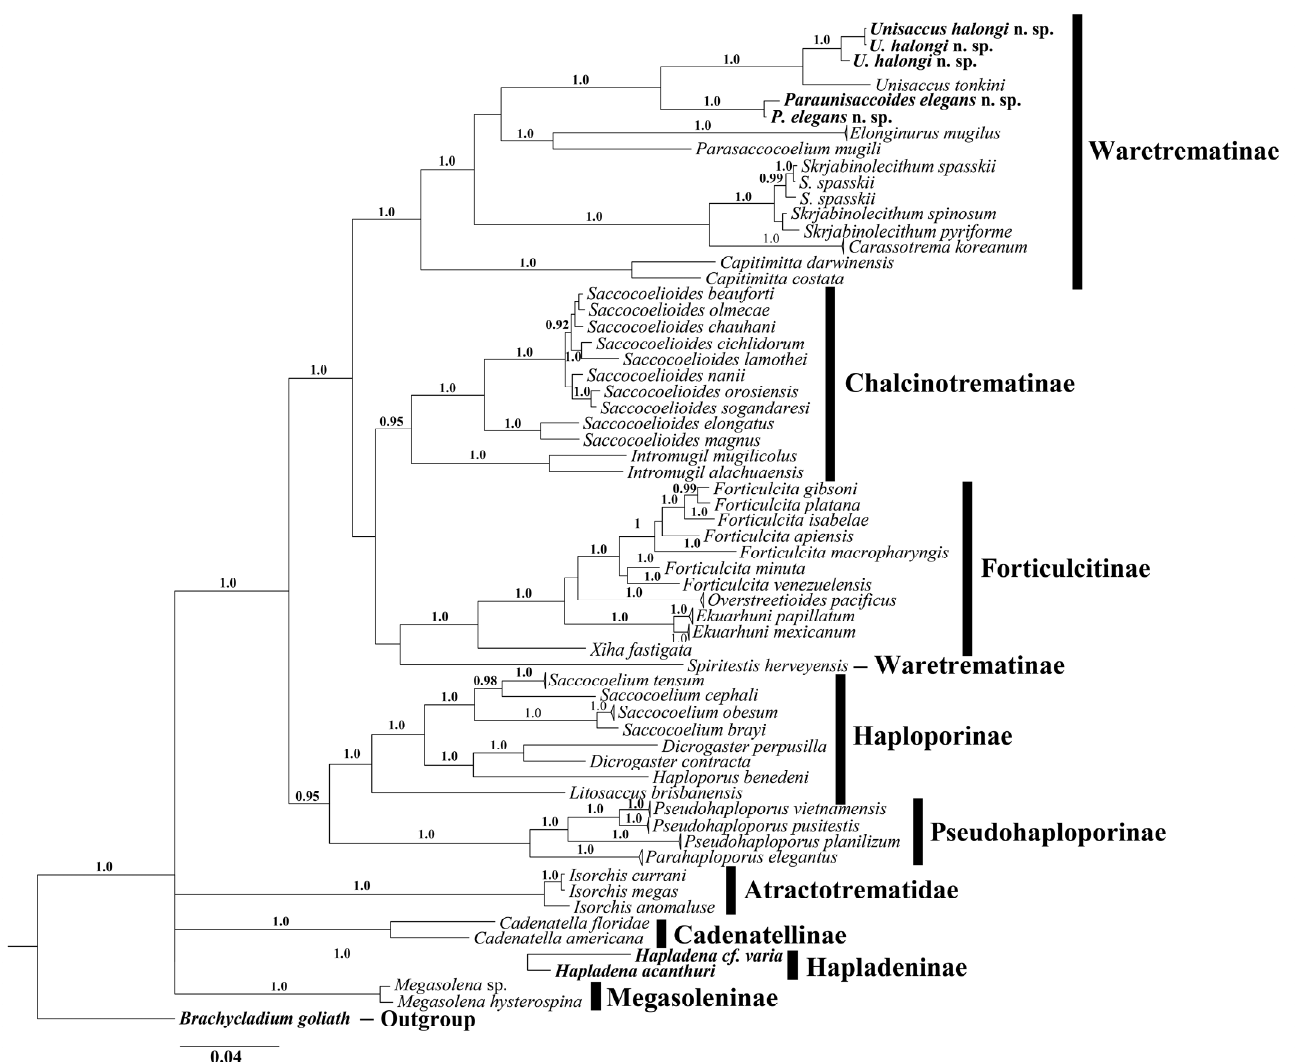
Figure 3. Phylogenetic relationships of the family Haploporidae obtained with Bayesian algorithm based on concatenated ribosomal ITS2 and partial 28S rRNA gene (alignment length 1460 bp). Nodal numbers—posterior probabilities that indicate statistical support of phylogenetic relationships, only significant values (0.9–1.0) are showed.